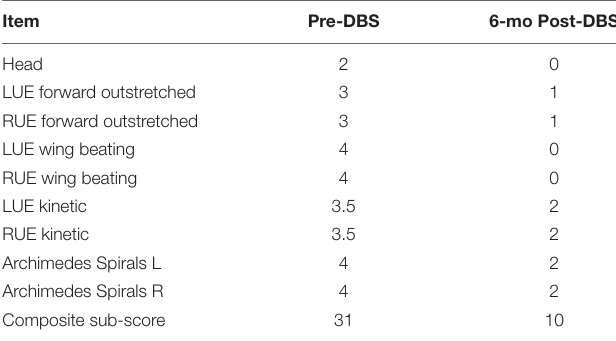
TABLE 1 | Performance subscale of The Essential Tremor Rating Assessment Scale